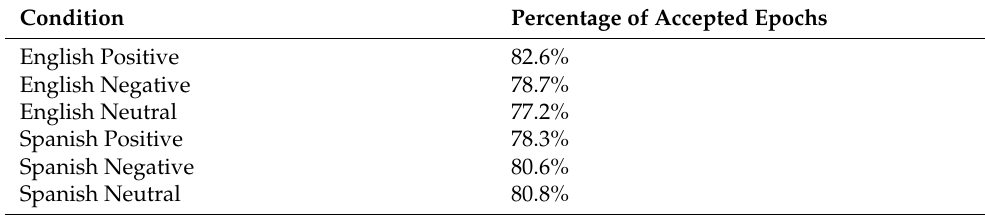
Table 3. Percentage of accepted epochs per condition in the EPN and LPC